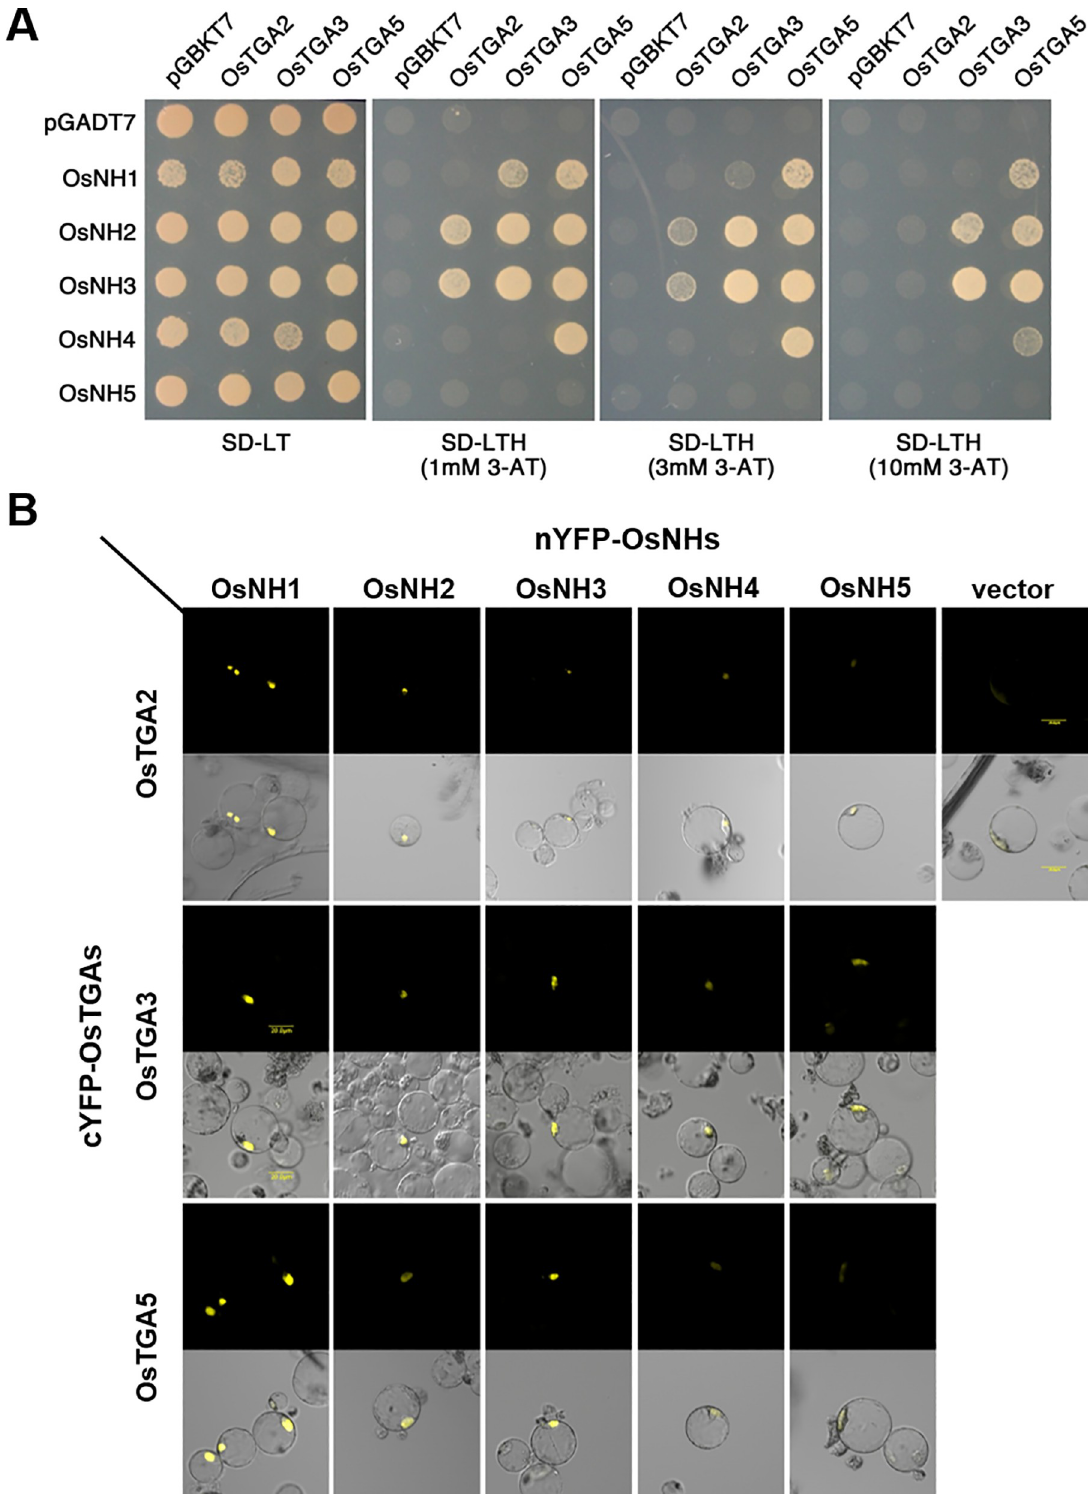
Fig 4. OsTGAs interacts with OsNHs. (A) Interaction of OsTGAs with OsNHs in yeast. OsTGA proteins fused to GAl4-binding domain (BD) were expressed in combination with OsNHs fused to GAL4 activation domain (AD) in yeast stain YH190. Cells were grown on selective media supplemented with 3-AT for 3 days at 30˚C before pictures were taken. (B) Visualization of nYFP-OsNHs and cFYP-OsTGAs interactions in rice protoplast by BiFC (Bar is 20 μ m). https://doi.org/10.1371/journal.pone.0206910.g004 PLOS ONE | https://doi.org/10.1371/journal.pone.0206910 November16,